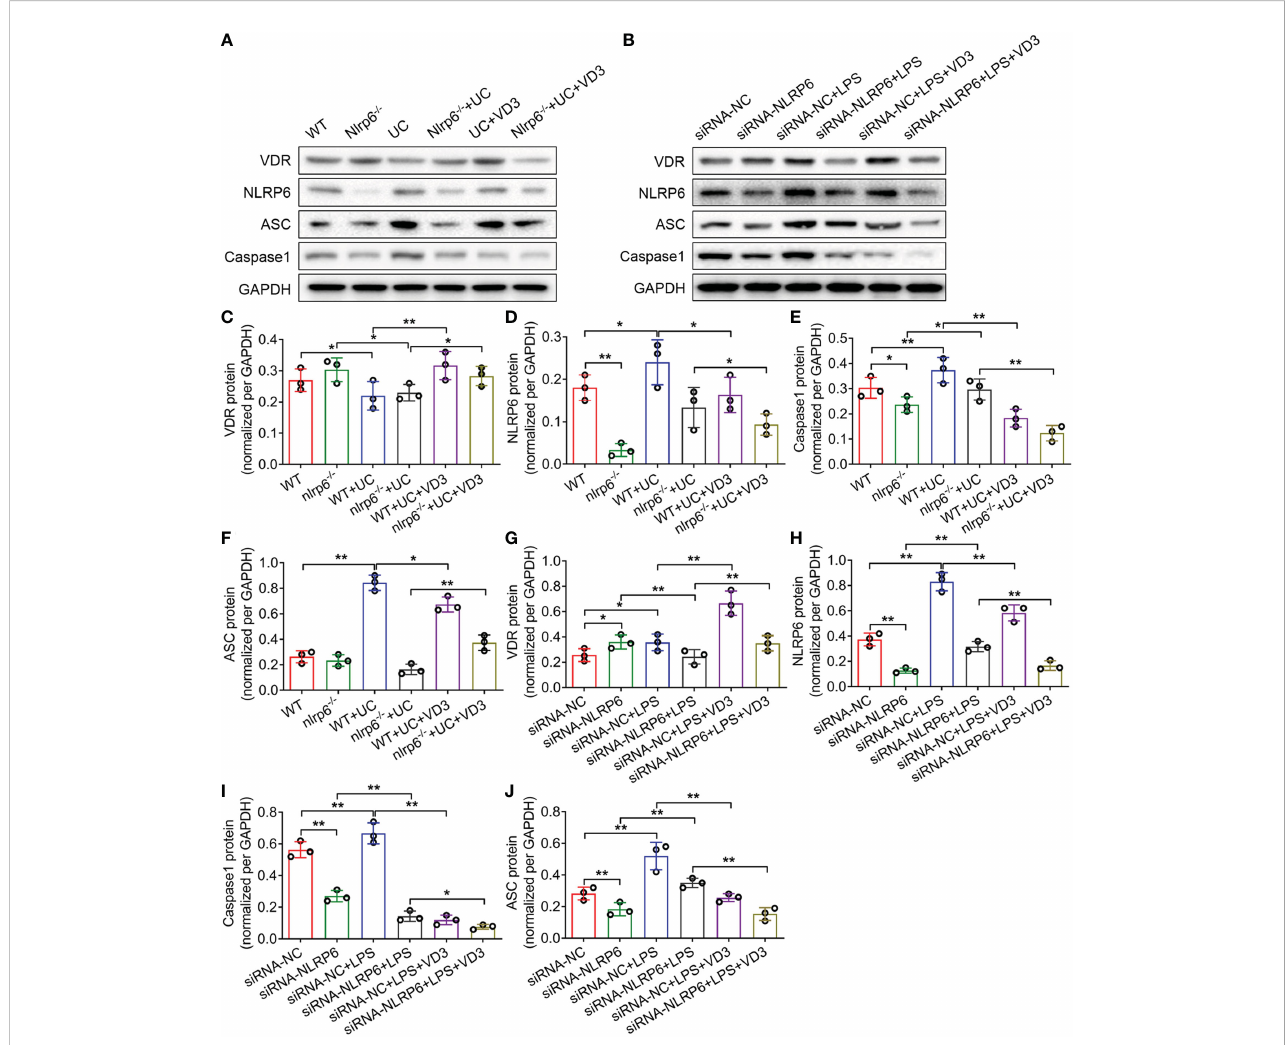
FIGURE 6 1,25(OH) 2 D 3 promotes NLRP6 expression in vivo and in vitro . (A) Western blot analyses were performed to evaluate the expression of the VDR, NLRP6, ASC and Caspase-1 proteins in Nlrp6 -/- mice and UC mice subsequently treated with VD 3 . (B) Western blot analyses were performed to evaluate the expression of the VDR, NLRP6, ASC and Caspase-1 proteins in NLRP6 siRNA MIECs that were then treated with LPS and incubated with VD 3 . (C – J) Quantitative analysis of the protein levels. The data are shown as the mean ± SD, n ≥ 3, * P < 0.05 , ** P < 0.01